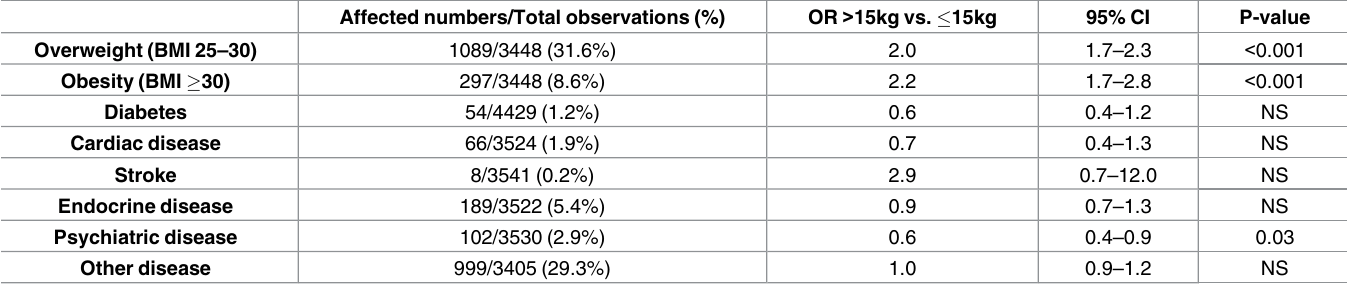
Table 3. High weight gain and the risk of different diseases10–17 years after